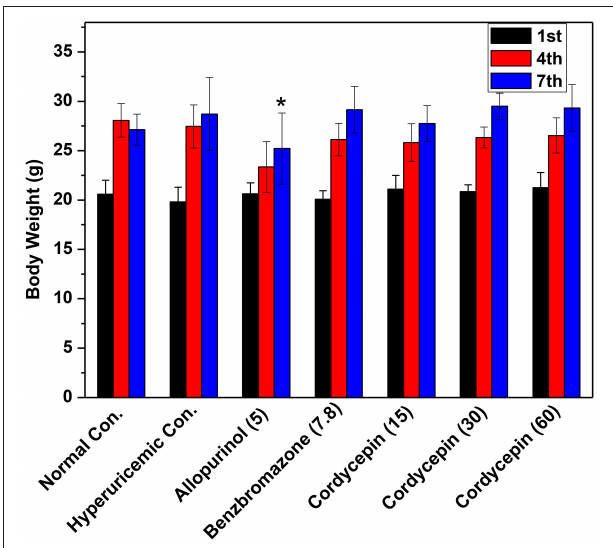
FIGURE 3 | Affections of cordycepin on the body weights of mice detected on the 1st, 4 th , and 7th days of experiments. * p < 0.05 vs. hyperuricemic